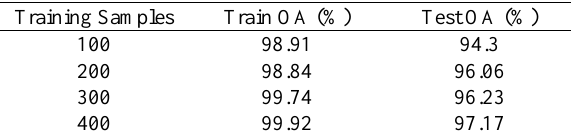
Table 3. Results obtained for classification of Salinas after